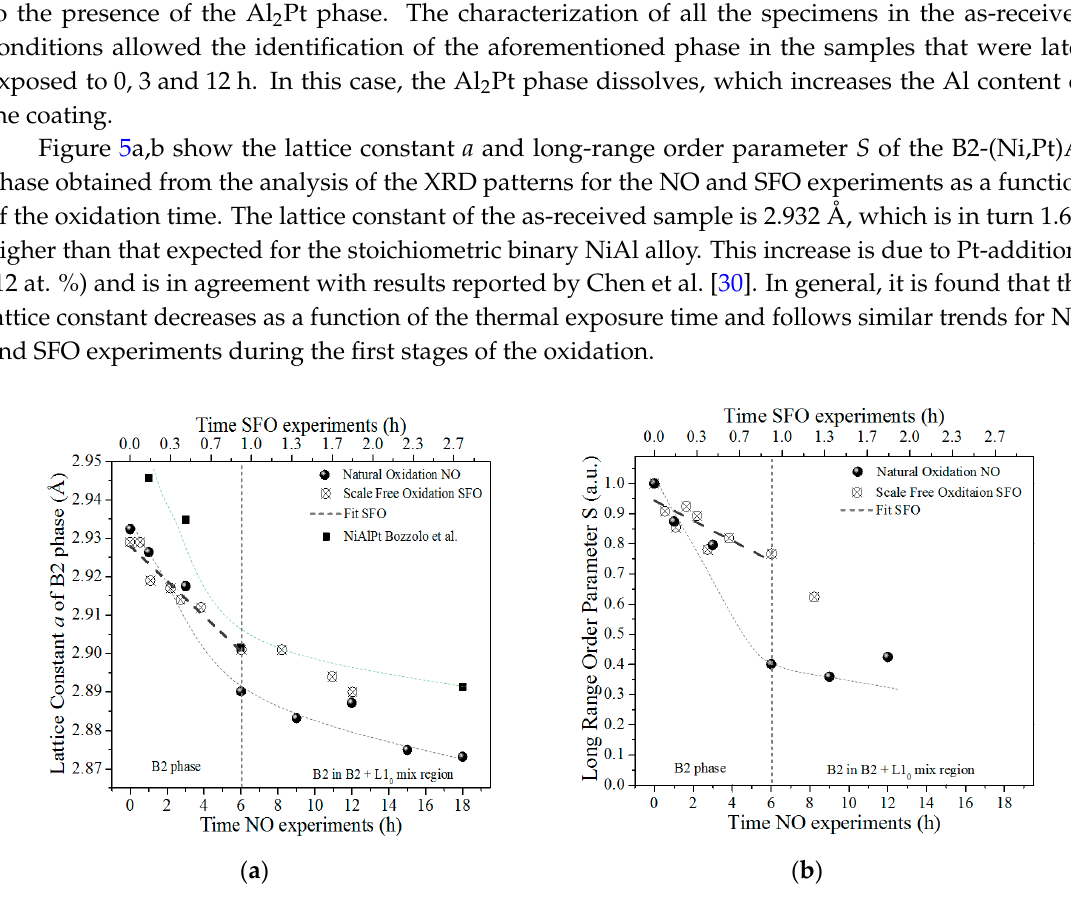
Figure 5. ( a ) Experimental and calculated lattice constant a of the B2 phase for NO and SFO experiments. ( b ) Long range ordering S of the B2 phase as a function of the exposure time for natural and scale free oxidation experiments. oxidation